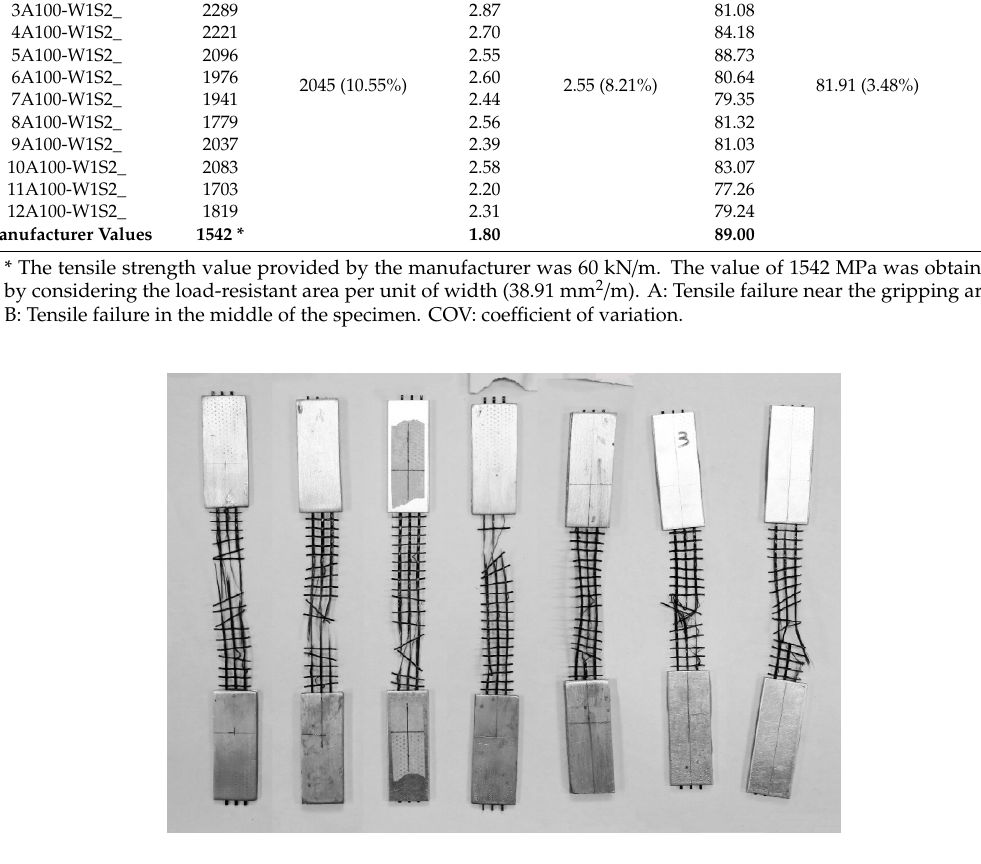
Figure 17. Basalt textile strips after failure.